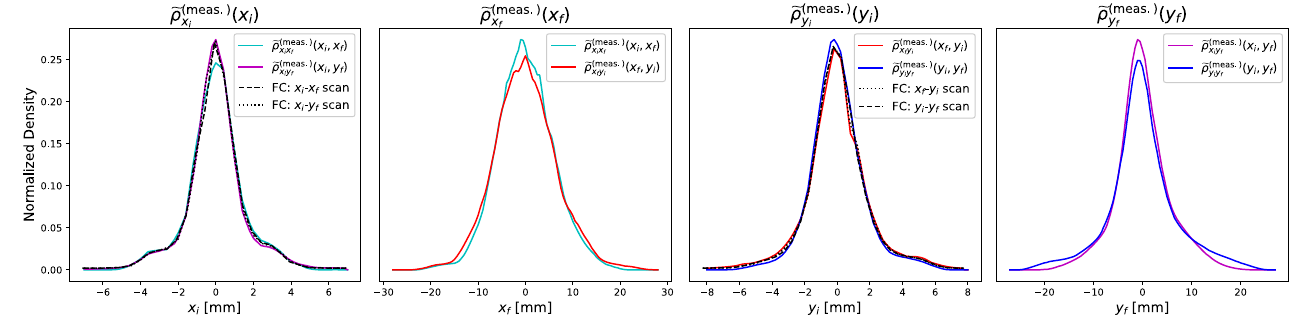
over the four 2D scan results at the SNS HEBT laser wire station. Each 1D profile can be obtained from two 2D scans, and both are plotted to illustrate their differences. The total variation distances between two different measurements of each 1D profile are shown in Table I. For x and y , the 1D profiles can also be measured separately by a Faraday cup which collected electrons stripped by the laser i i wire during the scan. These profiles, plotted in dashed and dotted lines, are consistent with projected 1D profiles from 2D scans and successfully verified their